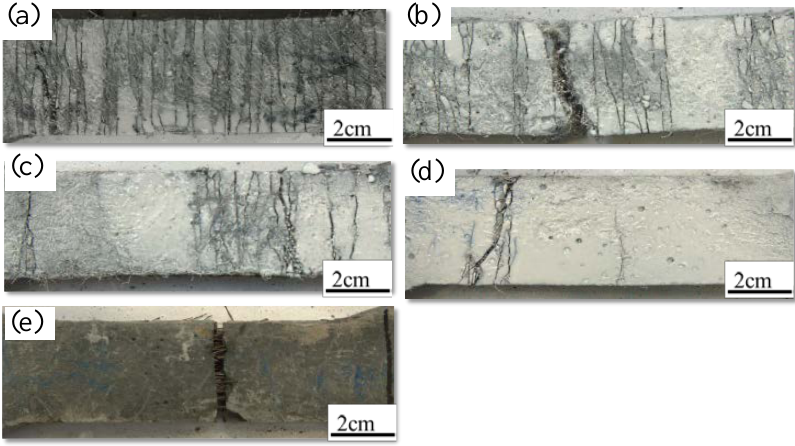
Figure 10. Multiple cracking behavior of different volume fractions of PE and ST fibers. ( a ) HUHP-2.0-0; ( b ) HUHP-1.5-0.5; ( c ) HUHP-1.0-1.0; ( d ) HUHP-0.5-1.5; ( e ) HUHP-0-2.0.